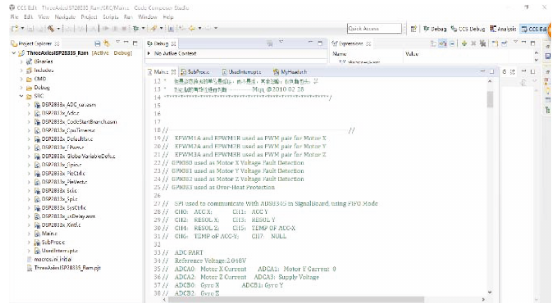
Figure 14: The control software. Figure 15: The upper computer